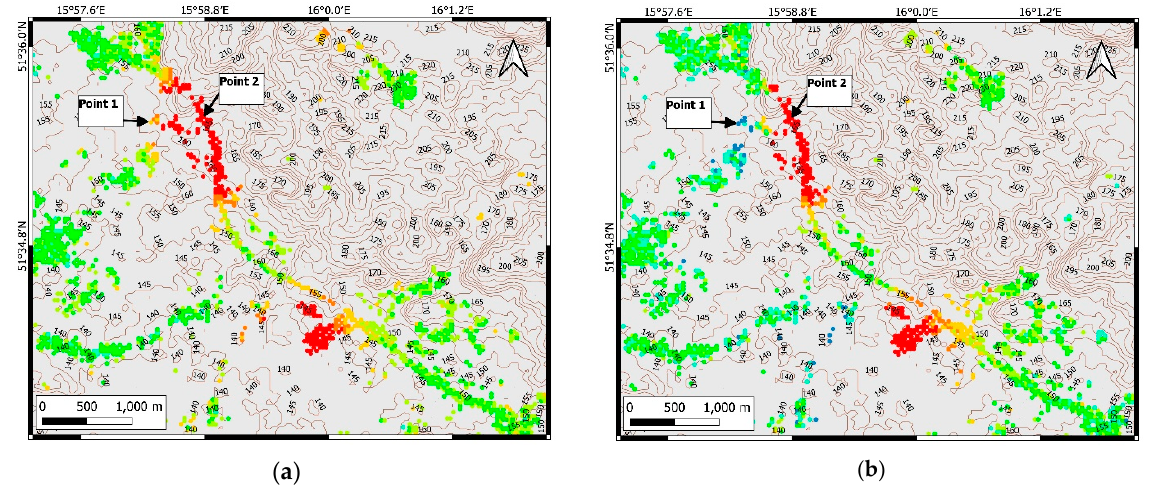
Figure 14. Up-down ( a ) and east-west ( b ) displacement maps of the area surrounding Przesieczna (area 3) and Borow (area 4), overlaid with the topographic contour lines of the selected area.